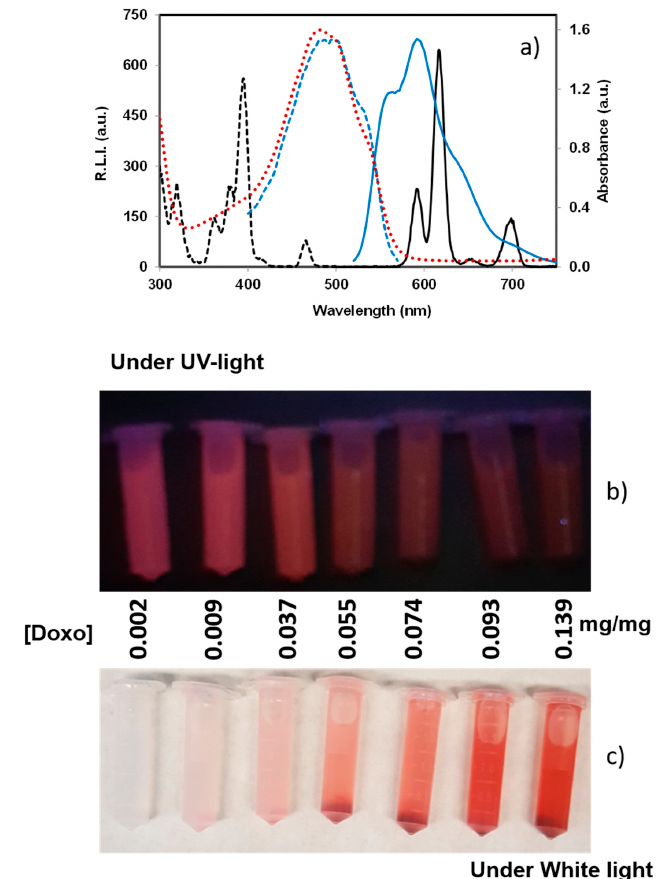
Figure 7. ( a ) excitation (black dashed line) and emission (black solid line) spectra of Eu:cit-cAp particles and excitation (blue dashed line), emission (blue solid line), and adsorption (red dotted line) of 0.01 mg/mL Doxo solution at the optima instrumental conditions (see Experimental Section). The pictures show: ( b ) the decrease of luminescence and ( c ) the increase of the light adsorption when the amount of immobilized Doxo increased on Eu:cit-cAp nanoparticles.